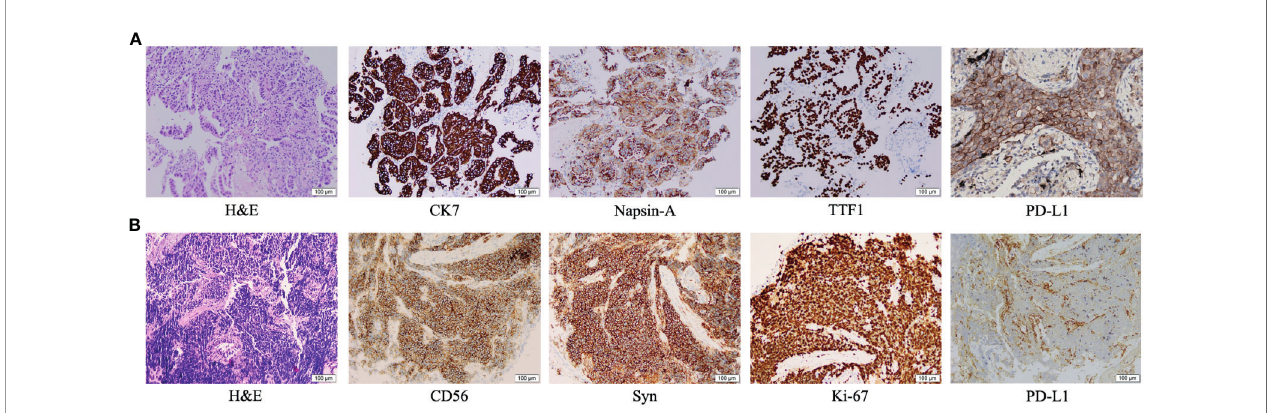
FIGURE 2 | Immunohistochemical examination: (A) Pathologic fi ndings from the right lower lobe lesion at the time of initial diagnosis showed adenocarcinoma (hematoxylin and eosin [H&E] staining), with positive immunohistochemical staining for CK7, Napsin-A, TTF1 and PD-L1. (B) Pathologic fi nding from the intraluminal lesion in the left bronchus at the time of progression showed small cell lung cancer (H&E), with positive immunohistochemical staining for CD56, synaptophysin and Ki-67, and negative staining for PD-L1.